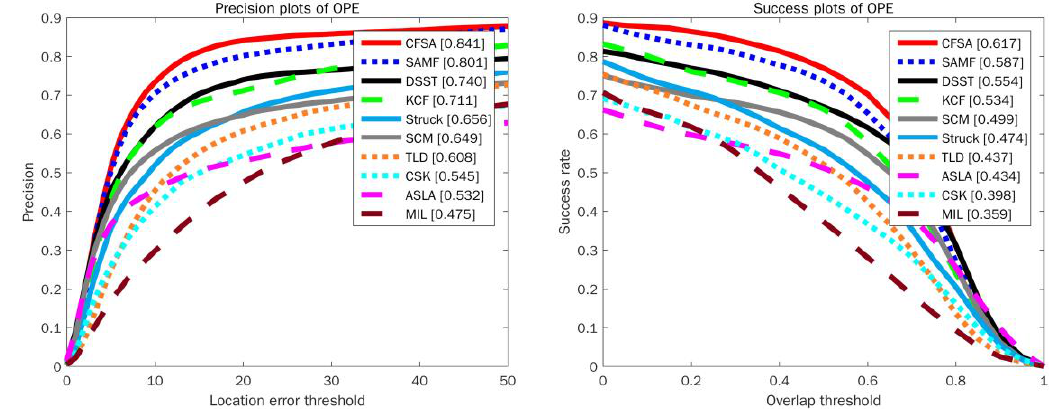
Figure 3. Precision and success plots over OOTB benchmark dataset using one-pass evaluation.